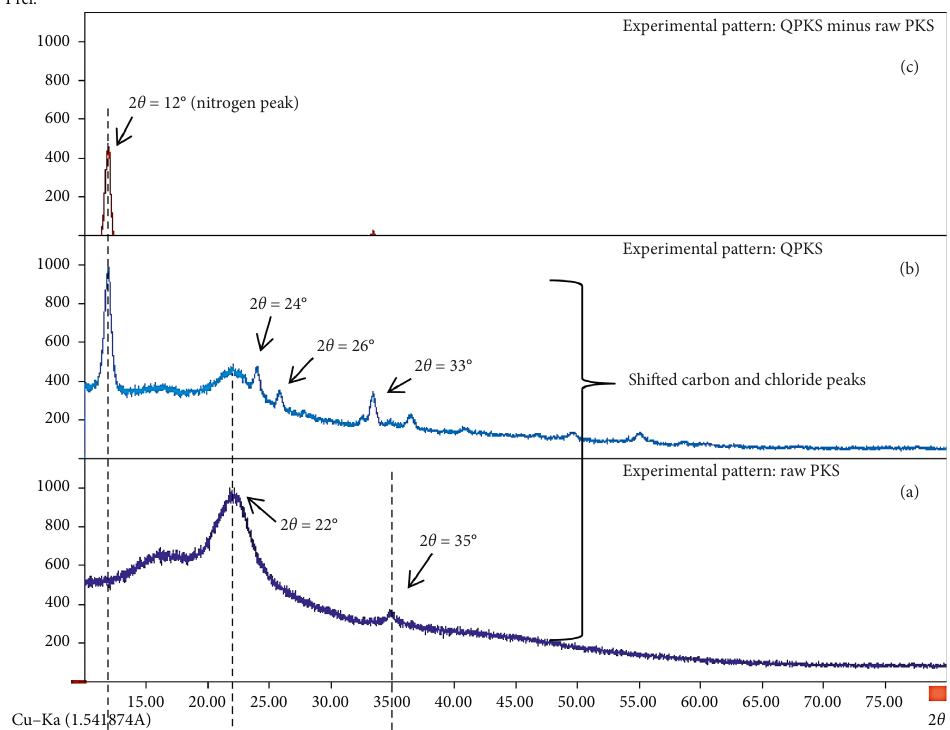
Figure 5: XRD peaks of (a) raw PKS, (b) QPKS, and (c) peak difference between raw PKS and QPKS. –1.5–1–0.500.511.5 0